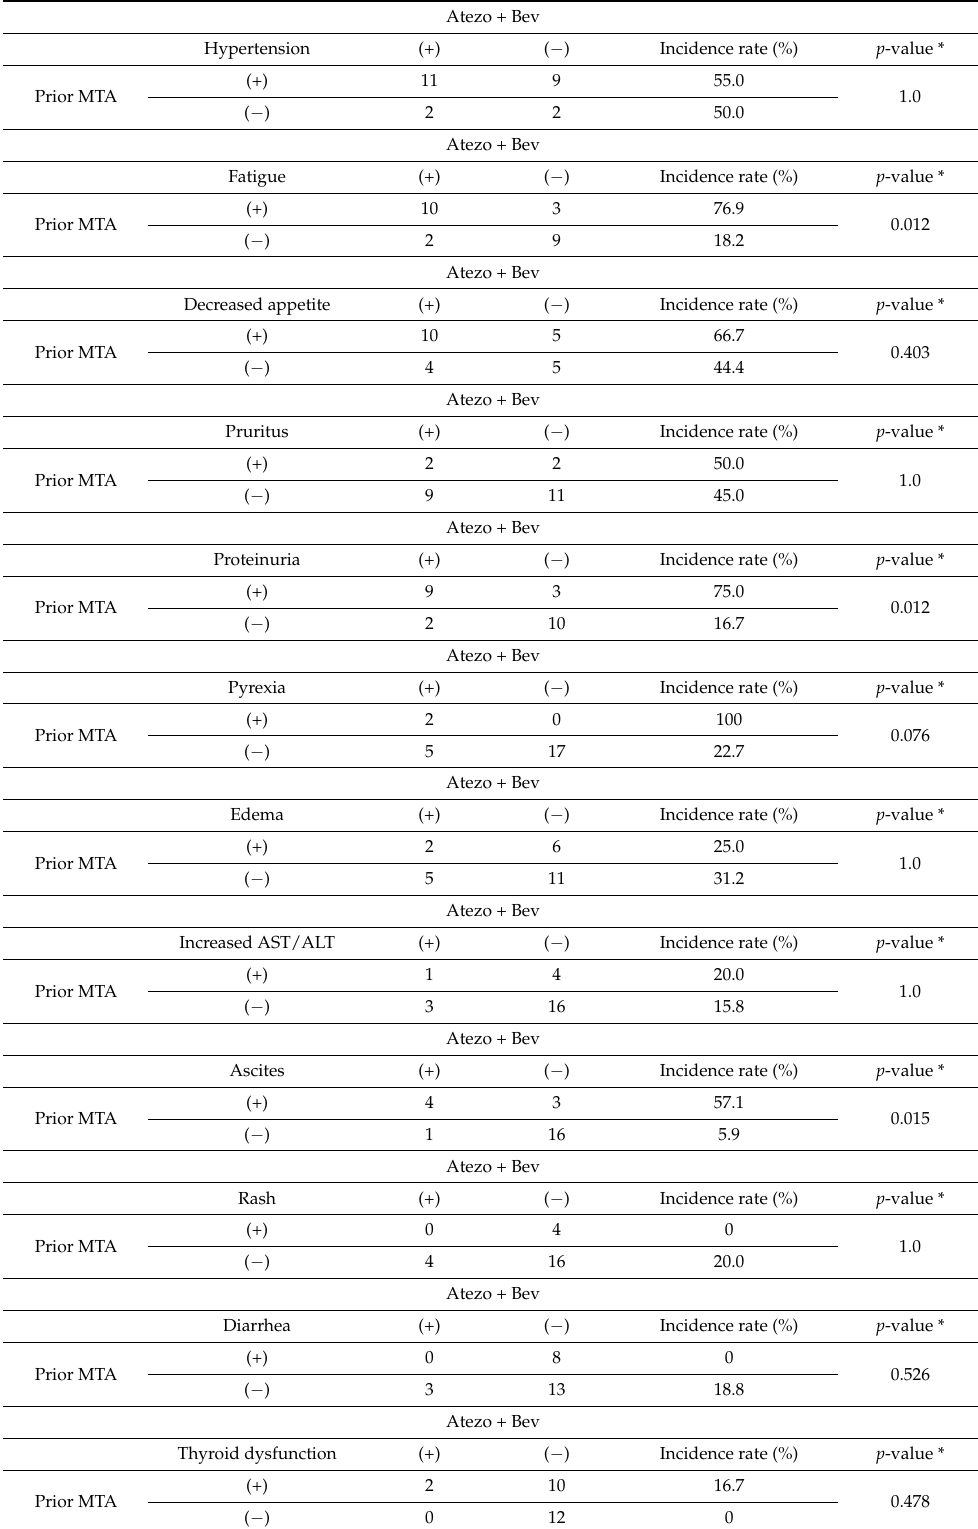
Table 6. Relationship of incidence between prior treatment and atezolizumab plus bevacizumab combination